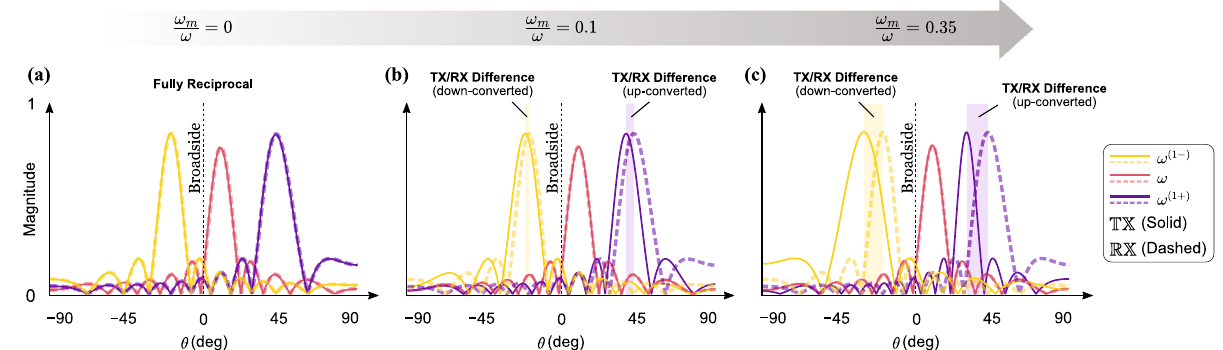
Figure 6. Nonreciprocity in the STP phased arrays demonstrated by a comparison between acoustic radiation patterns in TX and RX modes for increasing temporal modulations: ( a ) ω m /ω 0.1 , and ( c ) ω m /ω 0.35 . The parameters used are as follows: ω ω m /ω = = 2.9154 π and δ 1.5 κ m = =